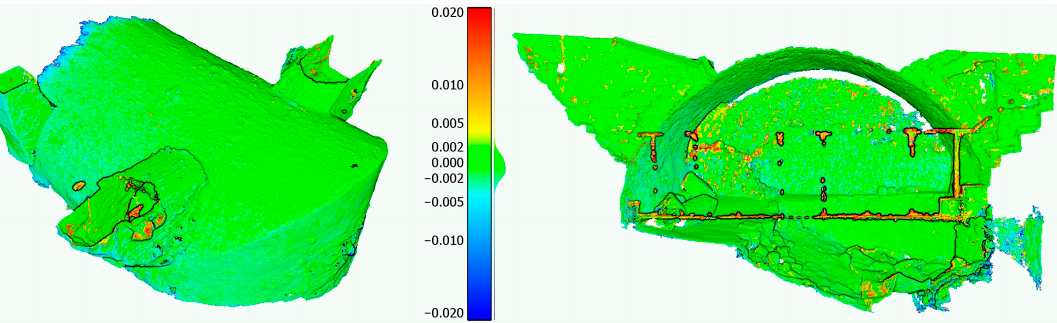
Figure 17. Deviations in the comparison of photogrammetry with all images active and the variant without connection through opening 3 (A vs. C) in the ossuary (external view on the left , cross-section on the right ).